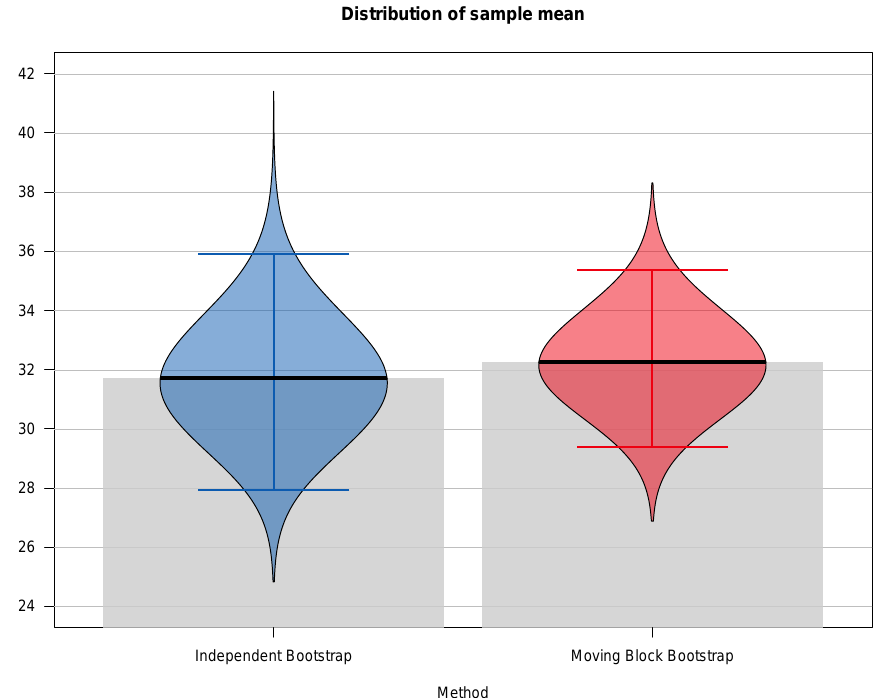
Figure 2. Empirical distributions of the sample mean based on the independent bootstrap (blue— incorrect approach) against moving block bootstrap (red—proper approach) for the Danish Fire Insurance Claims belonging to the reinsurance layer starting from 20M DKK (Danish crowns) up to 100M